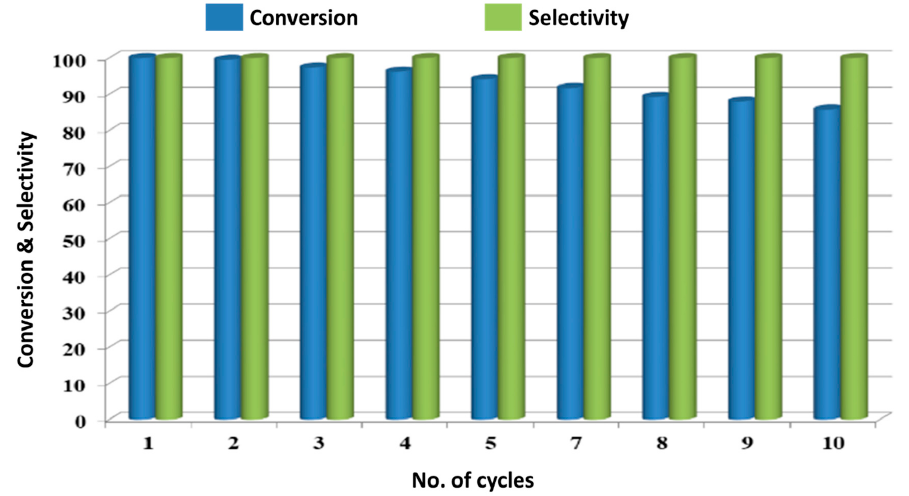
Figure 11. Reusability results of (1%)ZrO x –MnCO 3 / (1%)GRO nanocomposite. Conditions: 2 mmol BzOH, 0.3 g catalyst amount, 20 mL/min O 2 flow rate, 100 °C; 7 minutes.